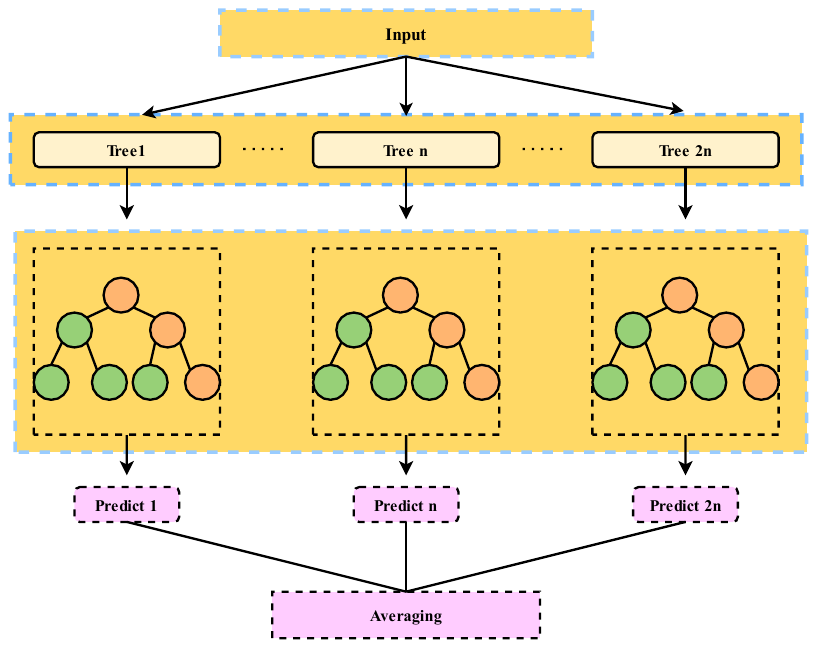
Figure 5. The structure of RF model.